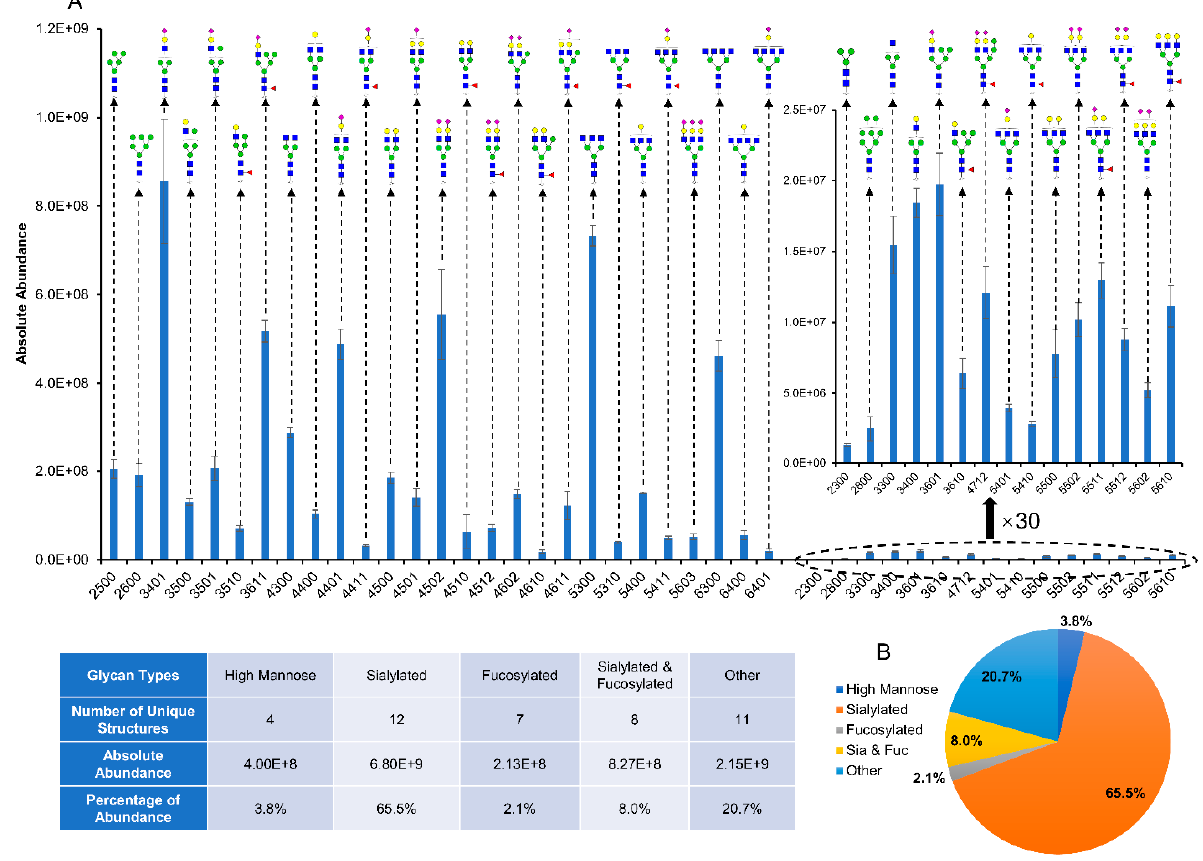
Figure 4. Quantification results of N -glycans extracted from egg yolks using oxidative release fol- lowed by acetone precipitation. ( A ) Absolute abundance of 42 identified N -glycans. ( B ) Distribution of five types of N -glycans. Symbols of monosaccharides are the same as shown in Figure